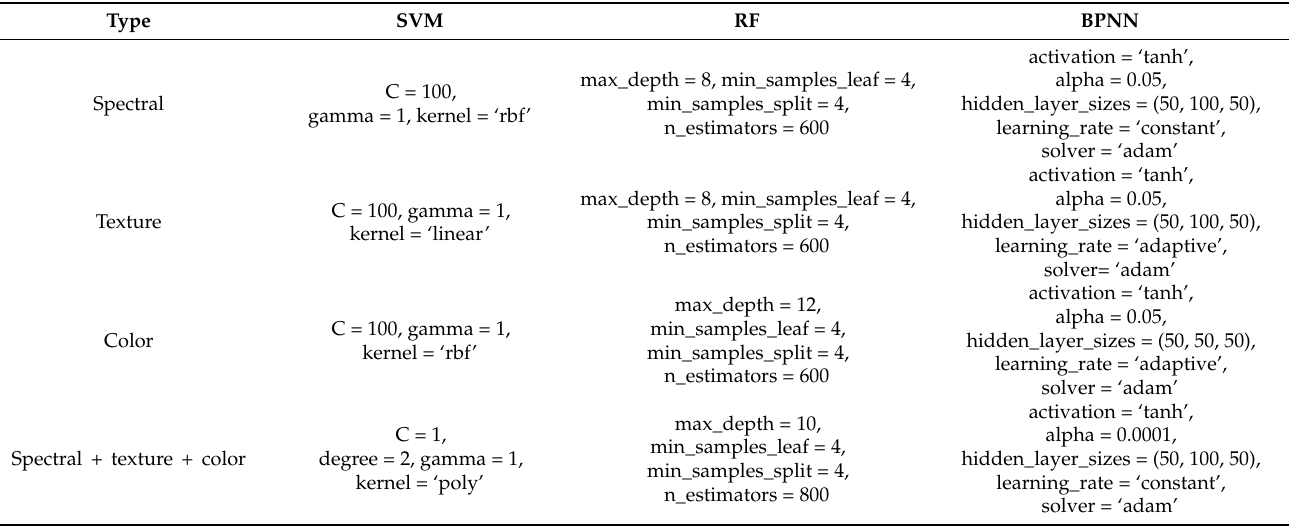
Table 6. Parameters of the SVM, RF, and BPNN models.